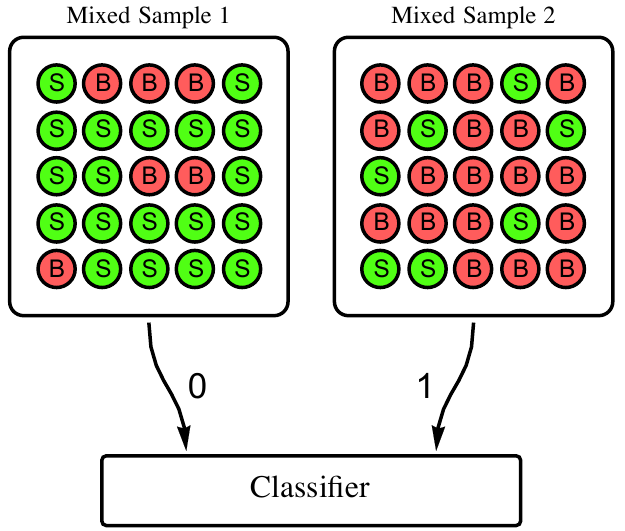
Figure 1 . An illustration of the CWoLa framework. Rather than being trained to directly classify signal ( S ) from background ( B ), the classi(cid:12)er is trained by standard techniques to distinguish data as coming either from the (cid:12)rst or second mixed sample, labeled as 0 and 1 respectively. No information about the signal/background labels or class proportions in the mixed samples is used during